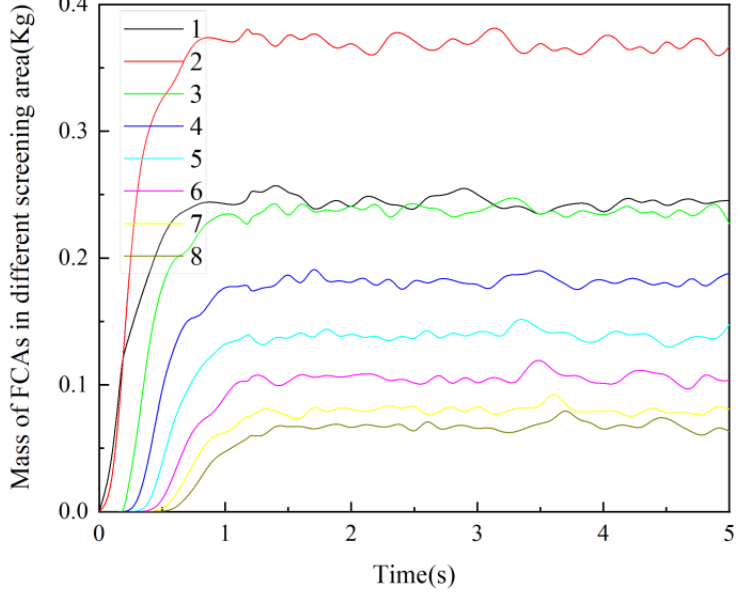
Figure 6. The particles distribution on screening surface.